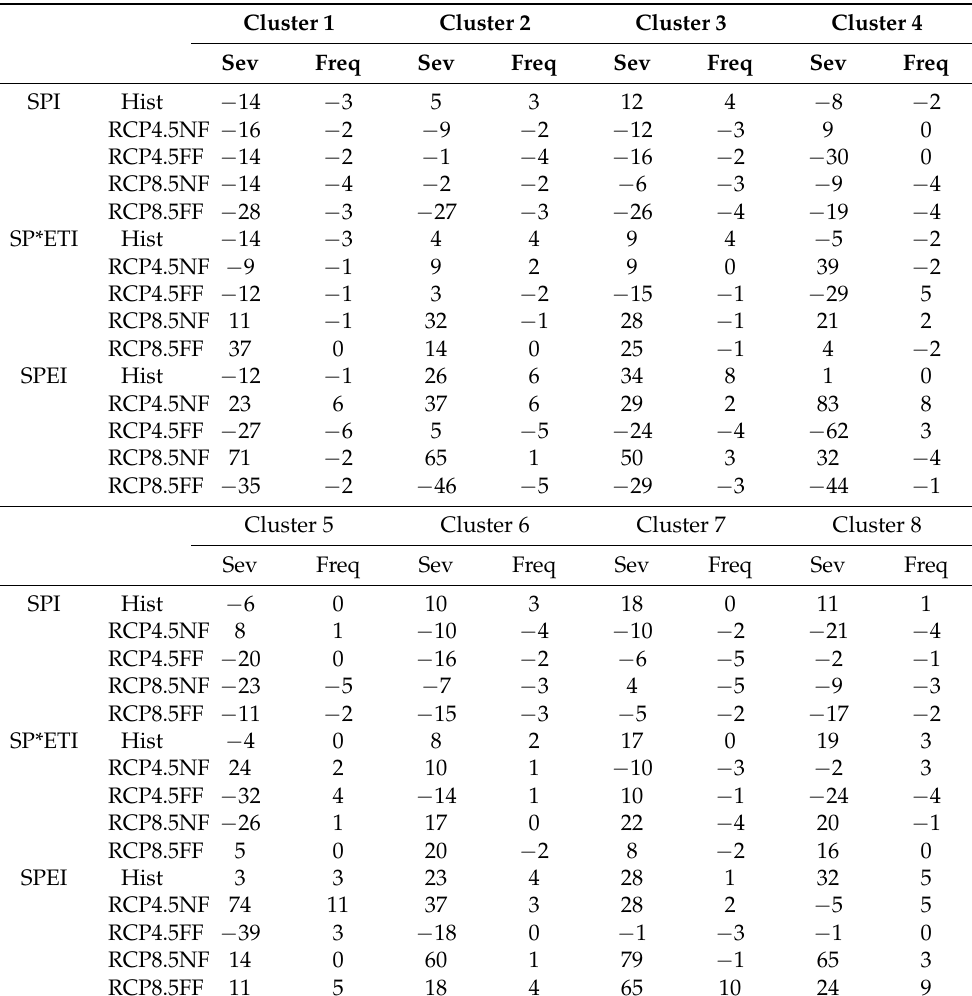
Table 3. Average values of Sen’s slope of the average annual severity and frequency of different clusters for Hist, NF, and FF (unit: 1‰). Positive values, “0” and negative values represent a significantly increasing trend, non-significant trend, and a significantly decreasing trend,